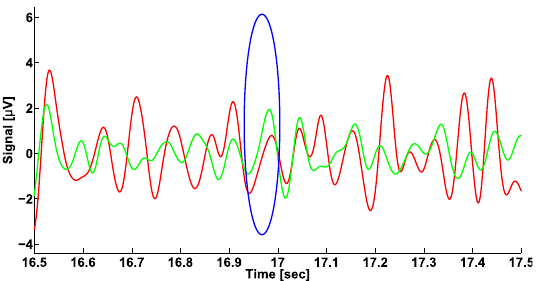
Figure 11. Example of the cross-wave train in frequency range from 8 to 18 Hz. Envelopes of EMG signals in antagonist muscles of left arm with hyperkinetic movements in a first-stage PD patient are demonstrated. The signals from the flexor and extensor muscles are indicated in green and red, respectively. Cross-wave train is indicated by a blue ellipse. The cross-wave train has the following characteristics: central frequency is 13.7 Hz, PSD is 3.86 µ V 2 / Hz, duration is 0.87 periods, frequency bandwidth is 2.6 Hz, and instantaneous phase is +0.3 radians. The abscissa axis indicates the time in seconds. The ordinate axis indicates the envelope of the signal in µ